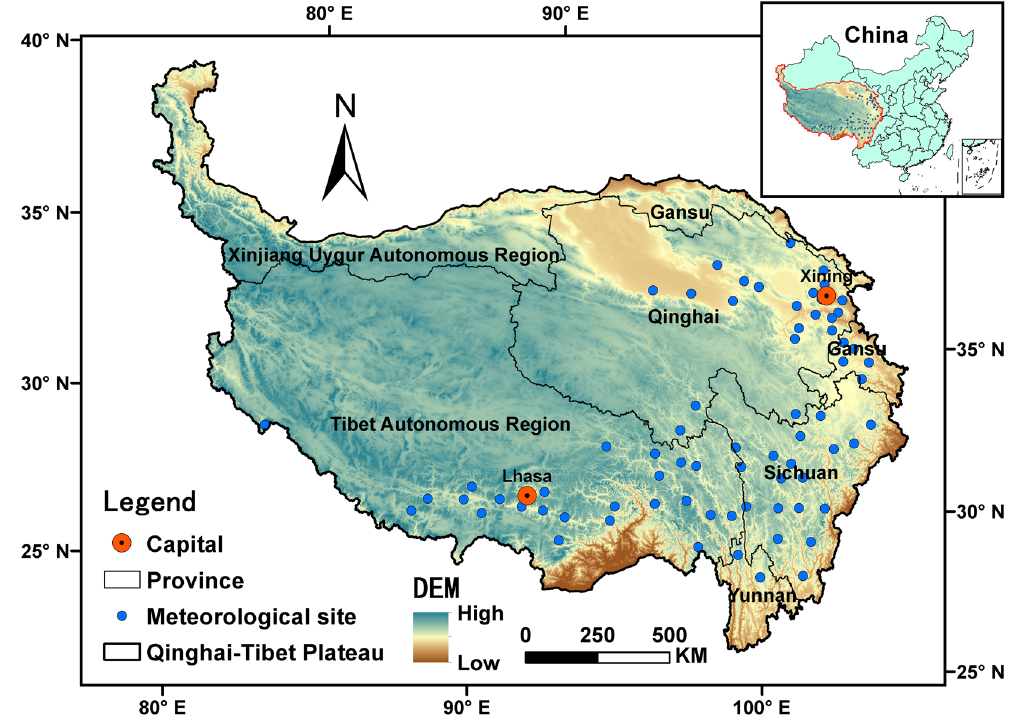
Figure 1. Boundary of the Qinghai-Tibet Plateau and location of 72 stations in the main sown region of highland barley. This map was generated using ArcMap 10.7 software ( © ESRI,